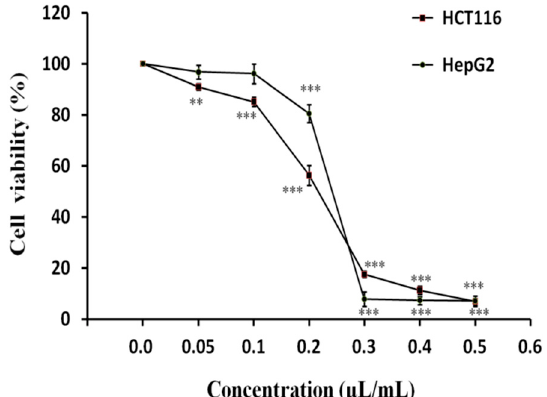
Figure 2. Effects on the viability of cancer cellsHepG2 and HCT116 as a function of LPEO concentration. Significant decreases in cell viability of cancer cells are seen at increasing LPEO concentrations compared to untreated controls (control group was set to 100%). **—Very significant at p < 0.01, ***—Highly significant at p < 0.001.